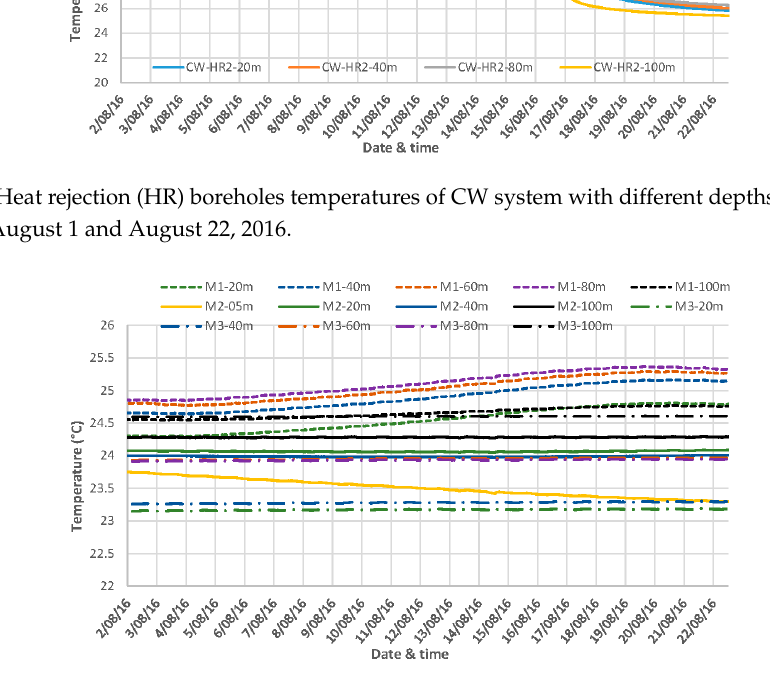
Figure 10. Monitoring boreholes (M1, M2, M3) temperatures of CW system from August 1 to August 22,